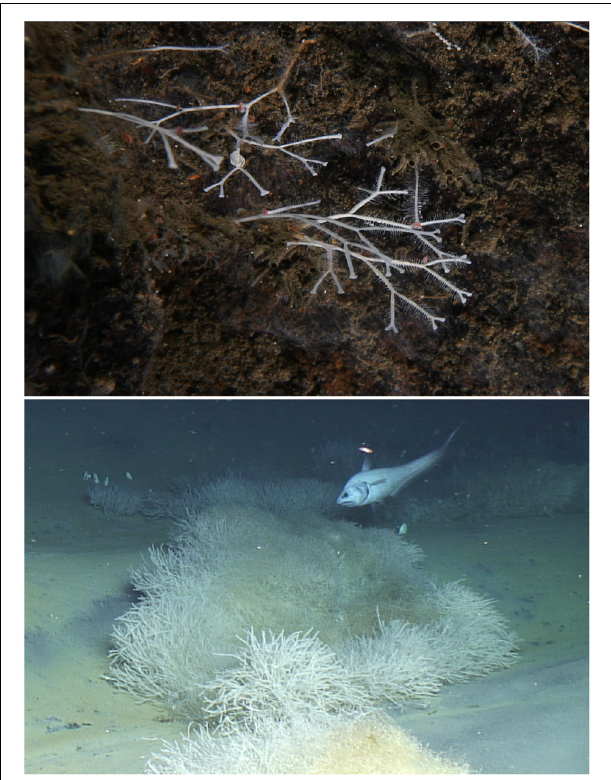
FIGURE 2 | In-situ images of Asbestopluma furcata (top) from the Troll Wall vent site (JMVF) and Cladorhiza methanophila (bottom) from the Atalante mud volcano (BAP). The BAP photo is courtesy of B. Ball, taken by ROV Jason operated by the Woods Hole Oceanographic